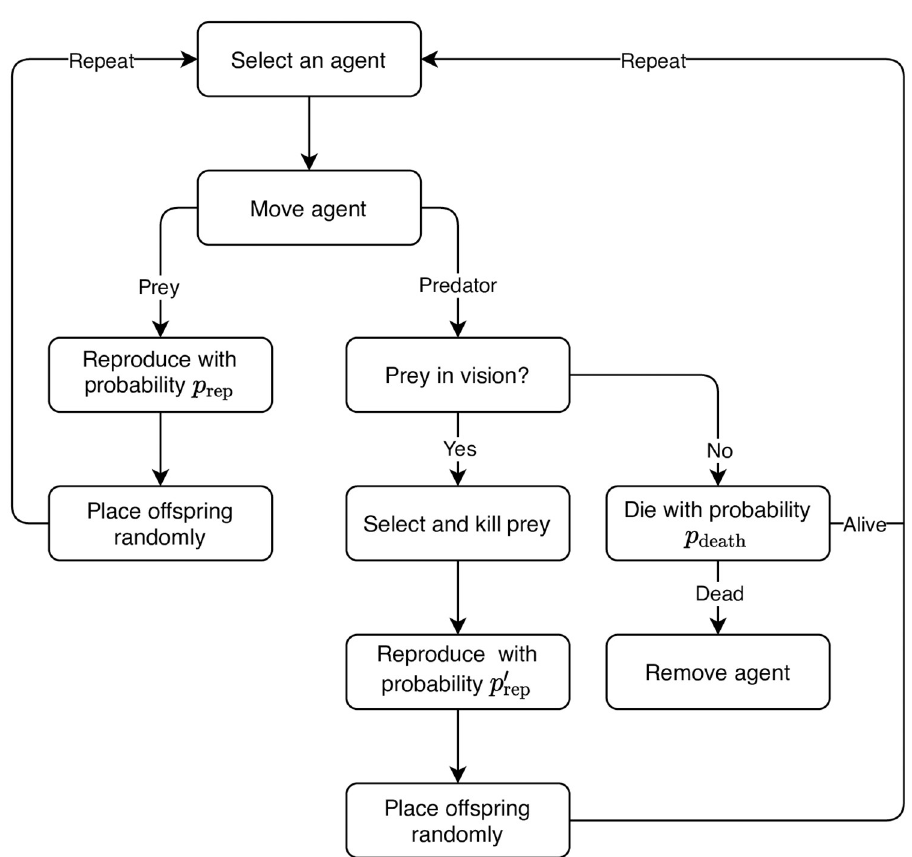
Fig 2. Predator-prey model. Flow chart of the predator-prey model.